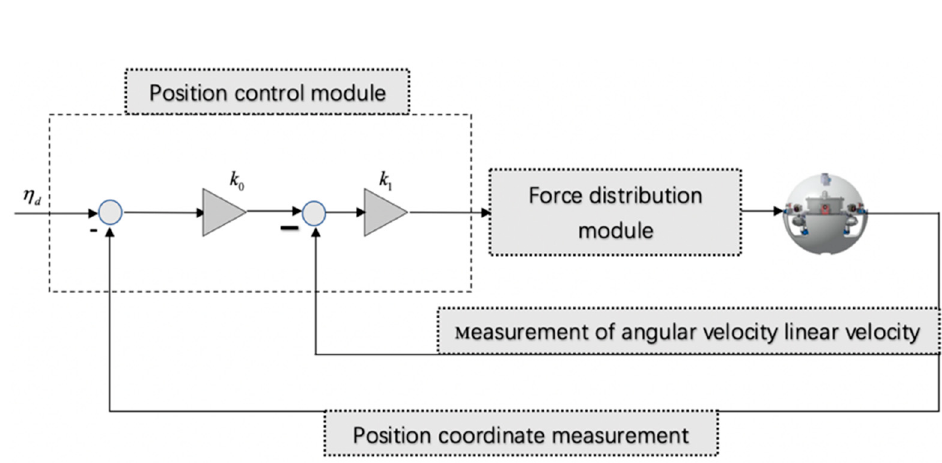
Figure 4. Aechitecture of the linear quadratic regulator control.